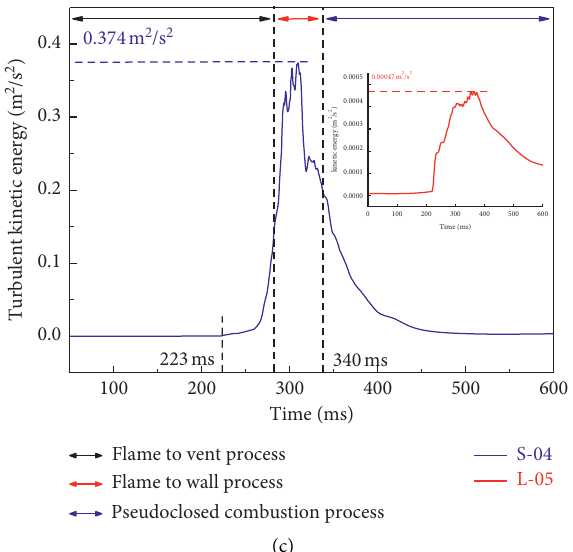
Figure 17: Comparison of flow-field parameters in the vicinity of congestion of the flat and abrupt cross section. (a) Combustion rate. (b) Gas flow velocity. (c) Turbulent kinetic